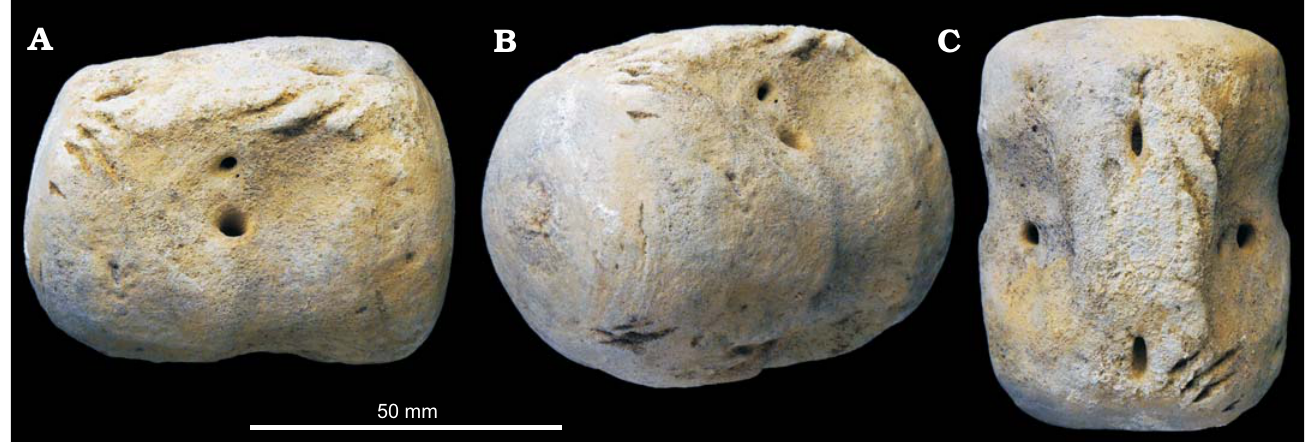
Fig. 3. A Miocene odontocete caudal vertebra, CMM-V-8406 from beach float at Willows Beach, Calvert Cliffs, Maryland, USA. Peduncular vertebra in right lateral ( A ), posterolateral ( B ), and dorsal ( C ) views. Multiple gouges are present on the top and bottom of the